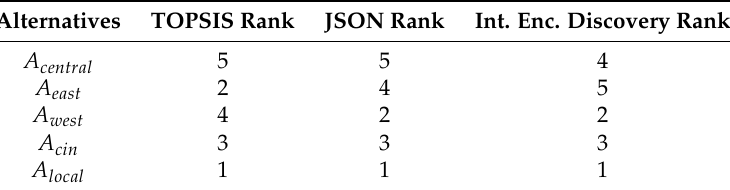
Table 3. Comparison of technique for order of preference by similarity to ideal solution (TOPSIS) ranking with test cases.